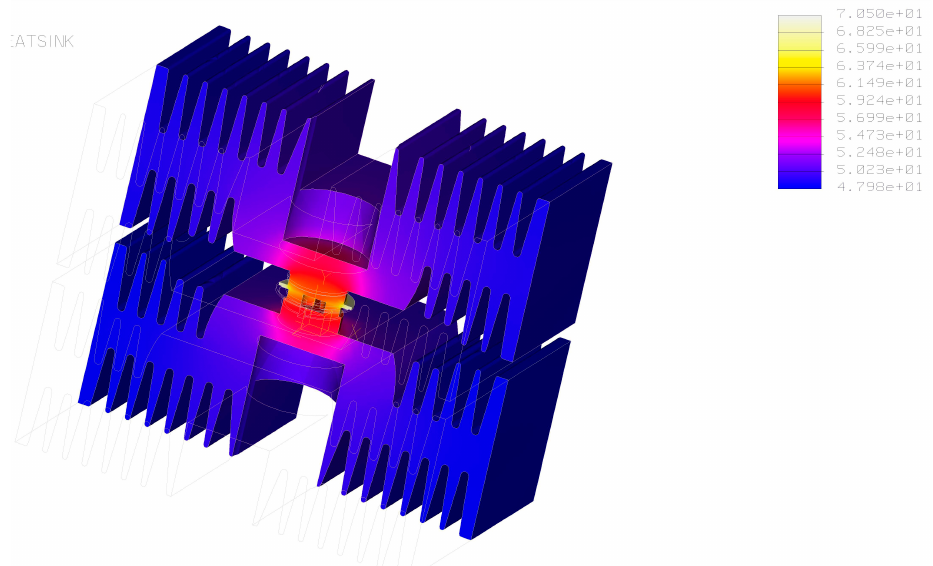
Figure 7. Temperature field through the thyristor mounted between heatsinks at 50% cross section, yz plane ( α = 50 °el, I = 250 A, v air = 3 m/s; R = 3 Ω , L = 30 mH).